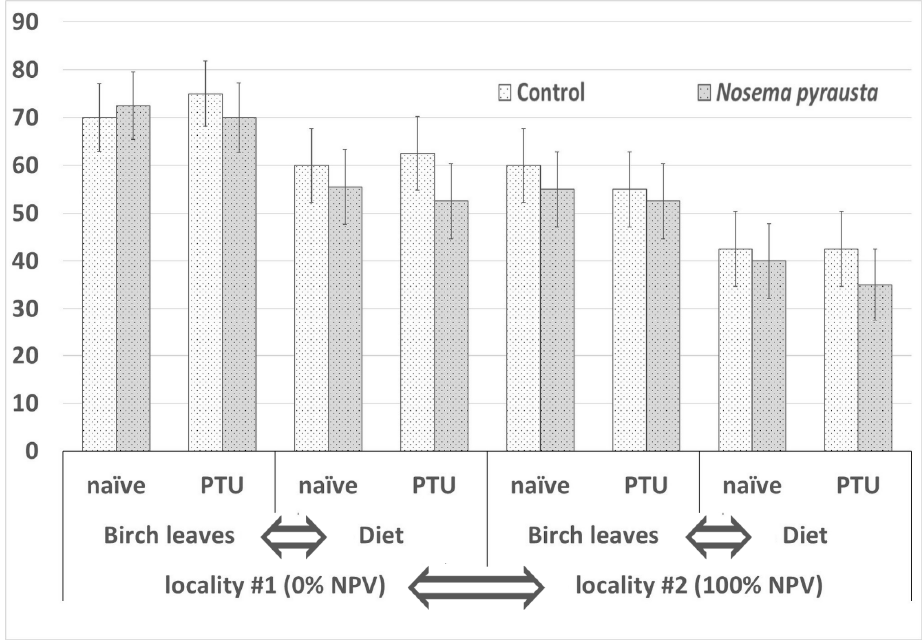
Figure 3. Survival levels in gypsy moth larvae 30 days after challenging with Nosema pyrausta spores. A generalized linear model was applied to test effects of four factors according to the experimental scheme shown in Figure 1. Factors causing statistically significant differences between the respective variants ( p < 0.01) are indicated by arrows.